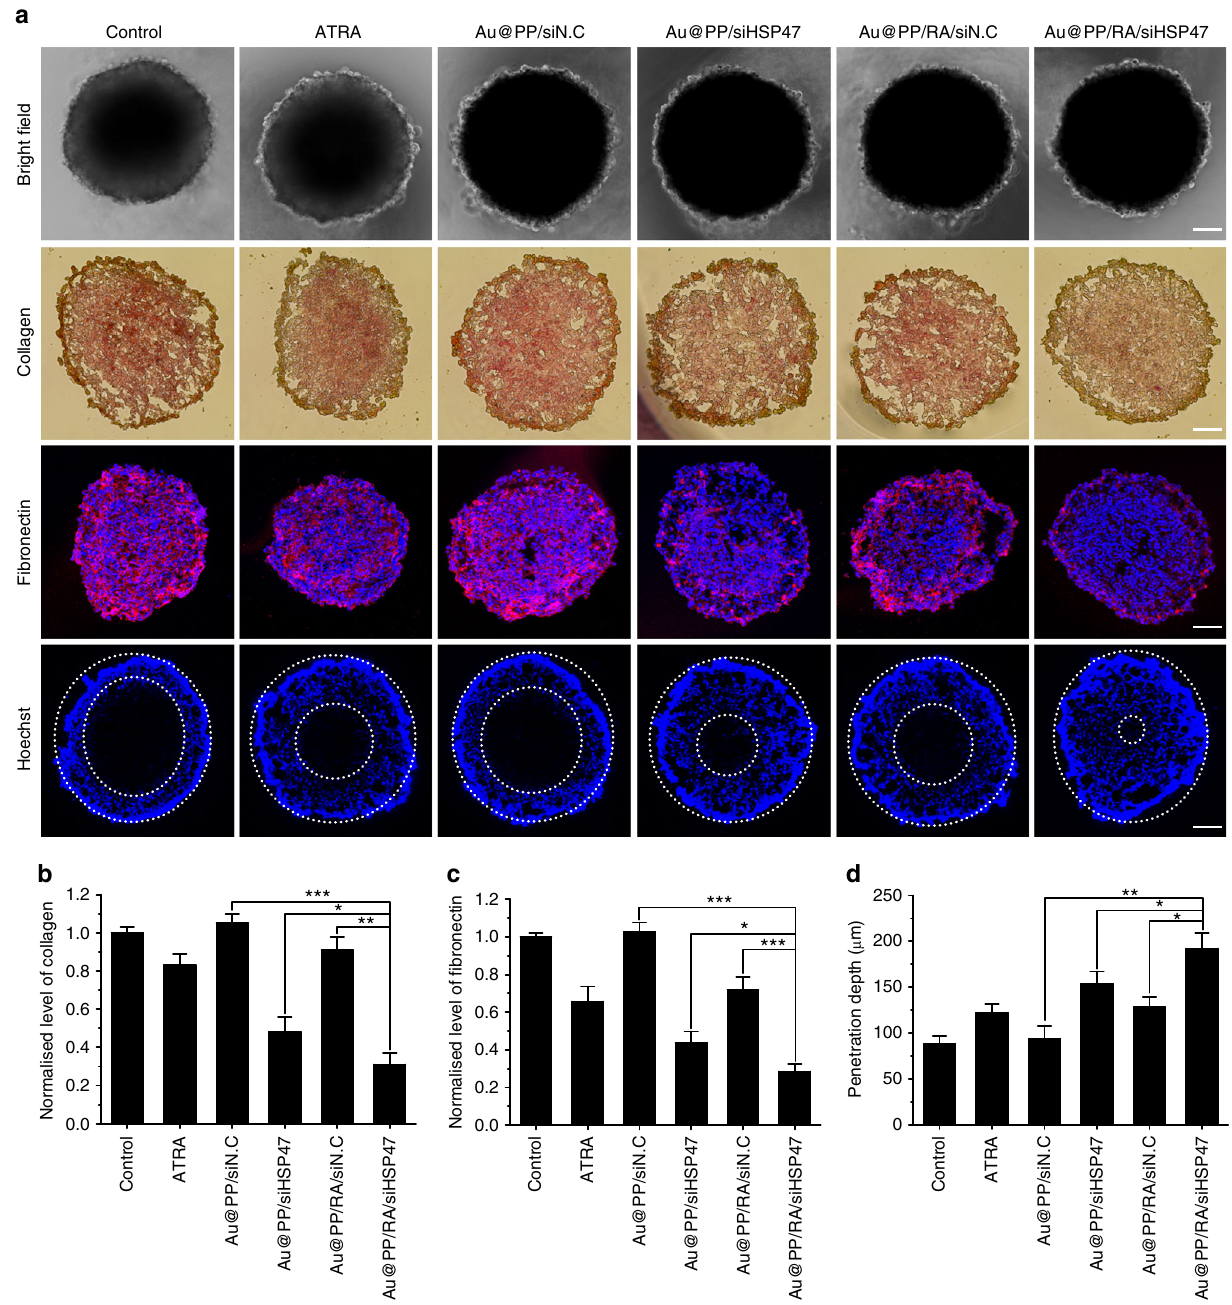
Fig. 5 Penetration of small molecules in Panc-1/PSC stroma-rich spheroids (PDAC-SS). PDAC-SS was generated by hanging drop culture of PSCs (pre- treated with different formulations) and Panc-1 cells. a Representative bright fi eld images, Sirius red staining images, fi bronectin immuno fl uorescence images and penetrated Hoechst 33342 fl uorescence images of PDAC-SS. Scale bars, 100 μ m. b – d Quanti fi cation of the normalised collagen positive (Sirius red stained) area ( b ), fi bronectin protein expression ( c ) and penetration depth of Hoechst 33342 (d; using Image J software). Hoechst 33342, a low- molecular weight fl uorescent DNA-binding dye, was used as a probe to visualise the penetrability of PDAC-SS. The data are shown as the mean ± s.d. ( n = 3). * p < 0.05, ** p < 0.01, *** p < 0.001 (Student ’ s t